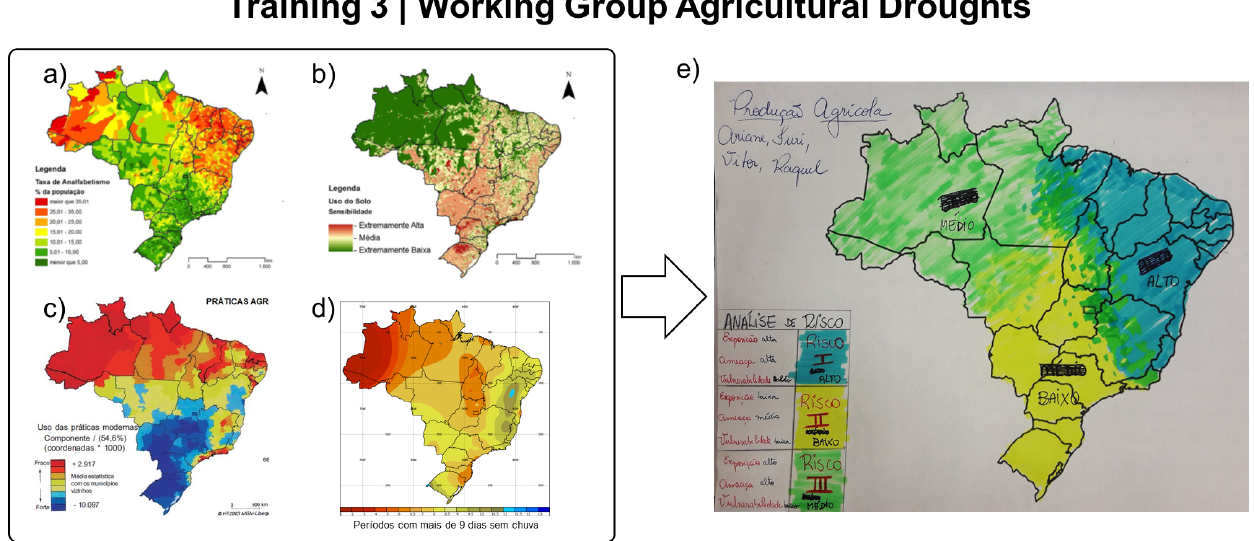
Figure A14. Package of maps used in the third training for mapping climate risk associated with agricultural droughts. The maps illustrate (a) illiteracy rate (MMA, 2017), (b) land use (MMA, 2017), (c) use of modern practices in agriculture (Théry and Mello, 2018), (d) number of dry spells longer than 9d (Normais climatológicas do Brasil, 2020), and (e) the climate risk map drawn by the participants.